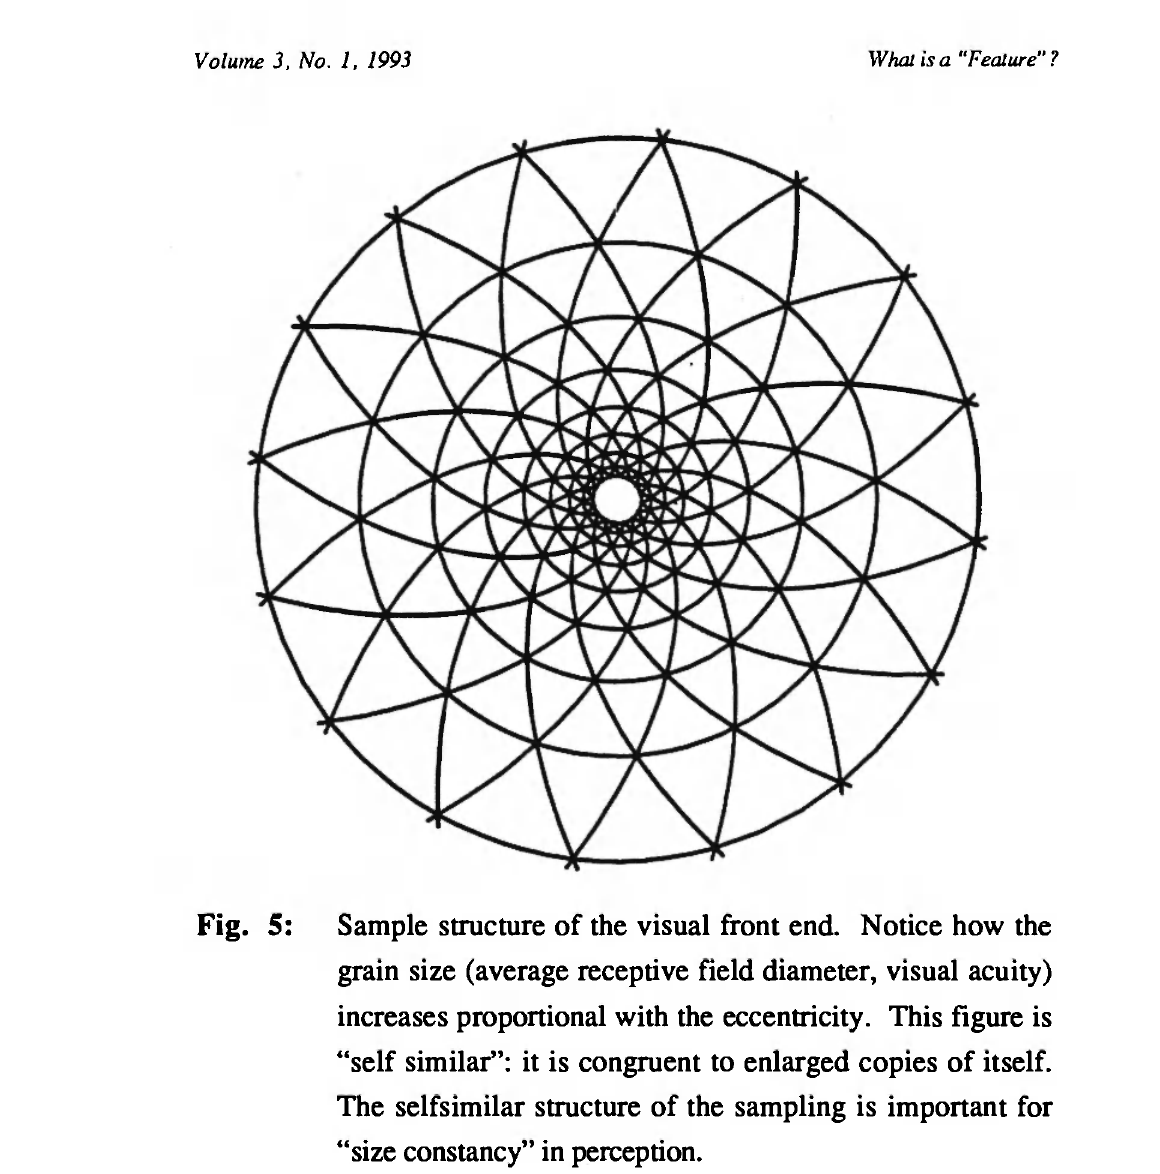
Fig. 5: Sample structure of the visual front end. Notice how the grain size (average receptive field diameter, visual acuity) increases proportional with the eccentricity. This figure is "self similar": it is congruent to enlarged copies of itself. The selfsimilar structure of the sampling is important for "size constancy" in